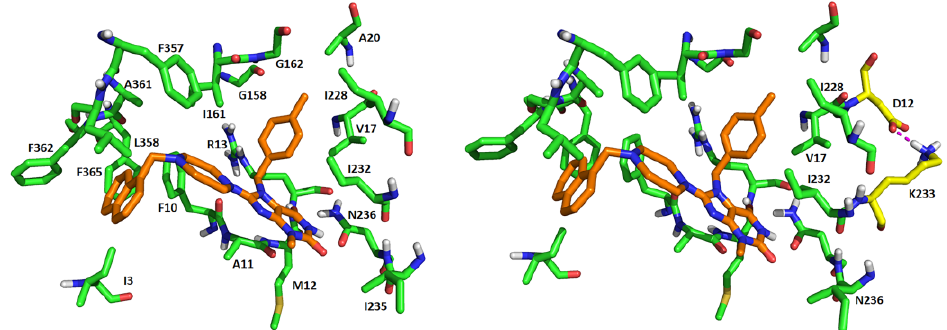
Figure 5. Two views of compound 262 in the binding pocket after MD simulations. Interactions with specific residues are shown.